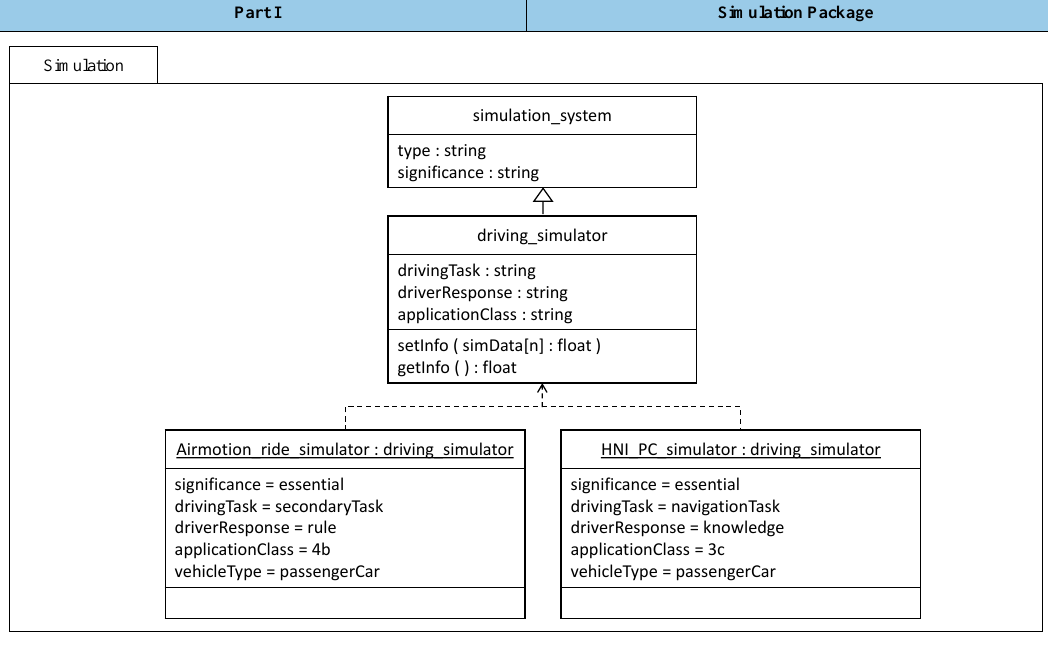
Figure 15. UML class diagram of the selected simulation system components—package 1.